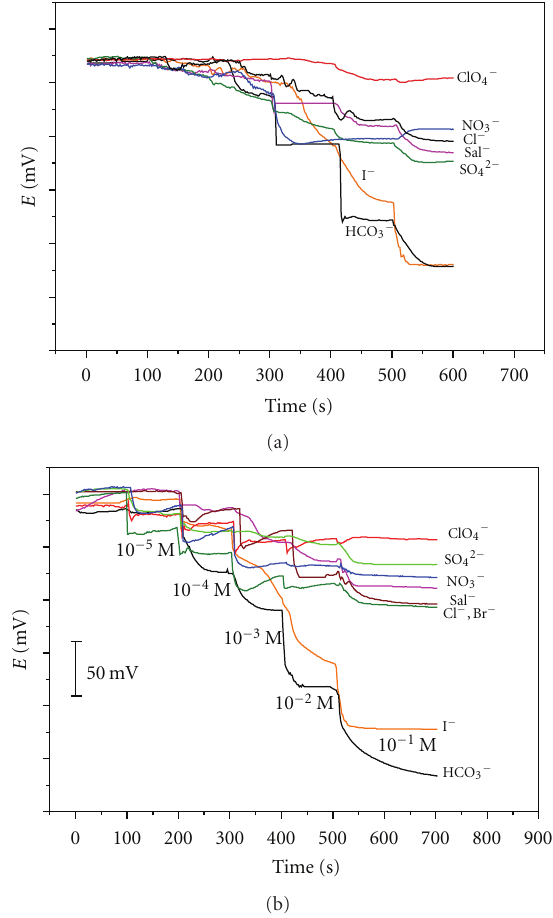
Figure 4: Potentiometric dynamic response of EP films towards several anions: (a) membrane I .d based on Co(II)TATPP and (b) membrane II based on